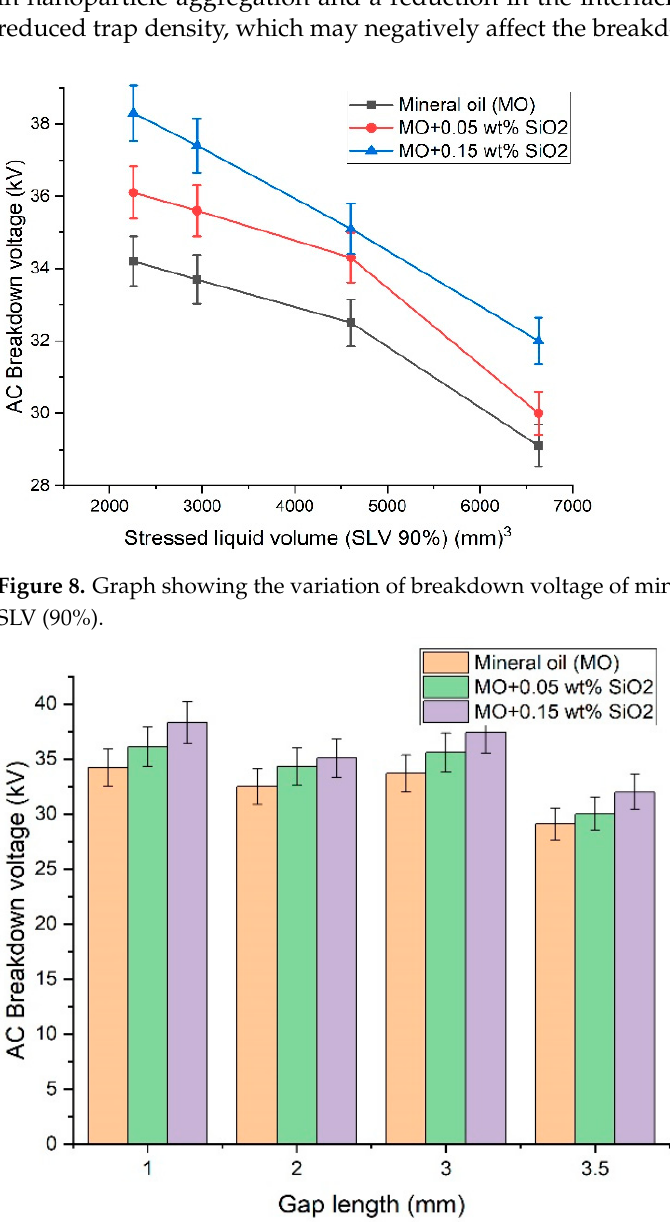
Figure 9. Graph showing the variation of breakdown voltage of mineral oil and its nanofluids with electrode gap length. Table 5. Breakdown voltage of mineral oil with 0.05 wt% nanoparticle concentration.